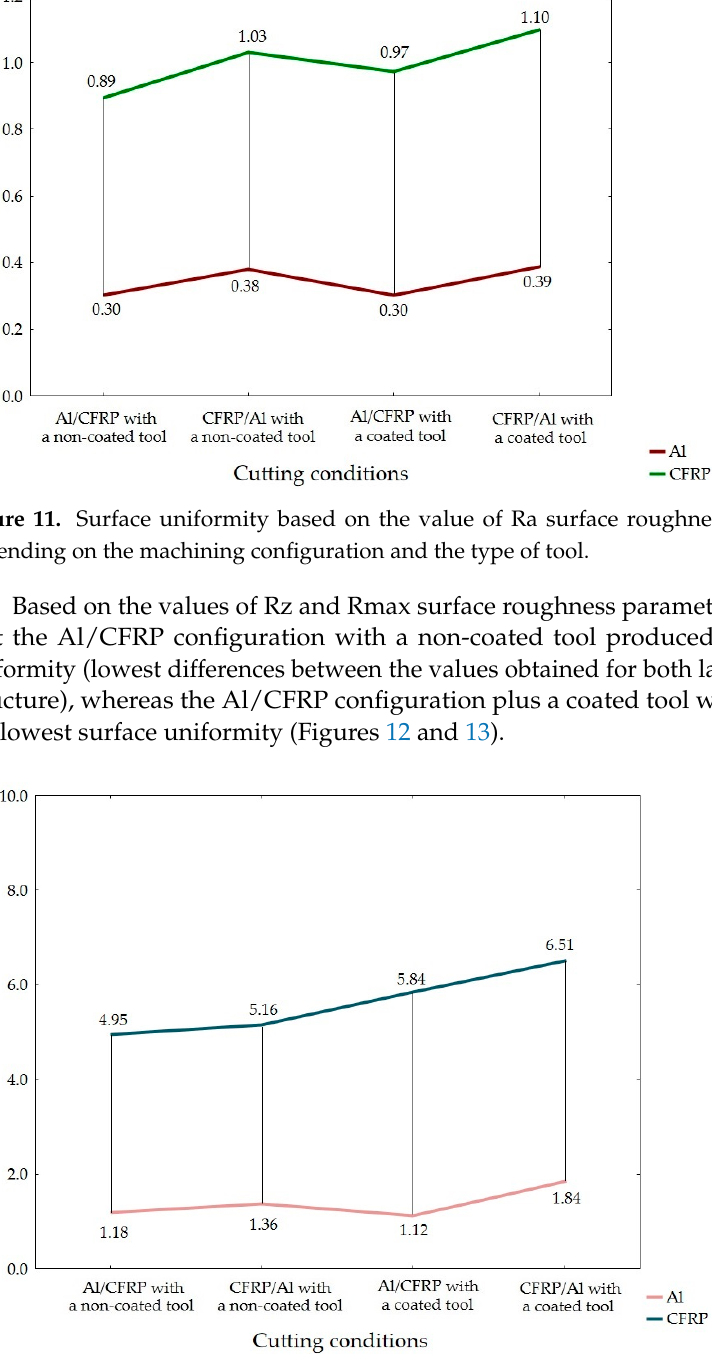
13 of 18 Figure 10. Surface topography after milling: ( a ) aluminum alloy in Al/CFRP configuration using a coated tool, ( b ) CFRP composite in Al/CFRP configuration using a coated tool, ( c ) aluminum alloy in CFRP/Al configuration using a coated tool, and ( d ) CFRP composite in CFRP/Al composite con- figuration using a coated tool. 3.4. Surface Uniformity